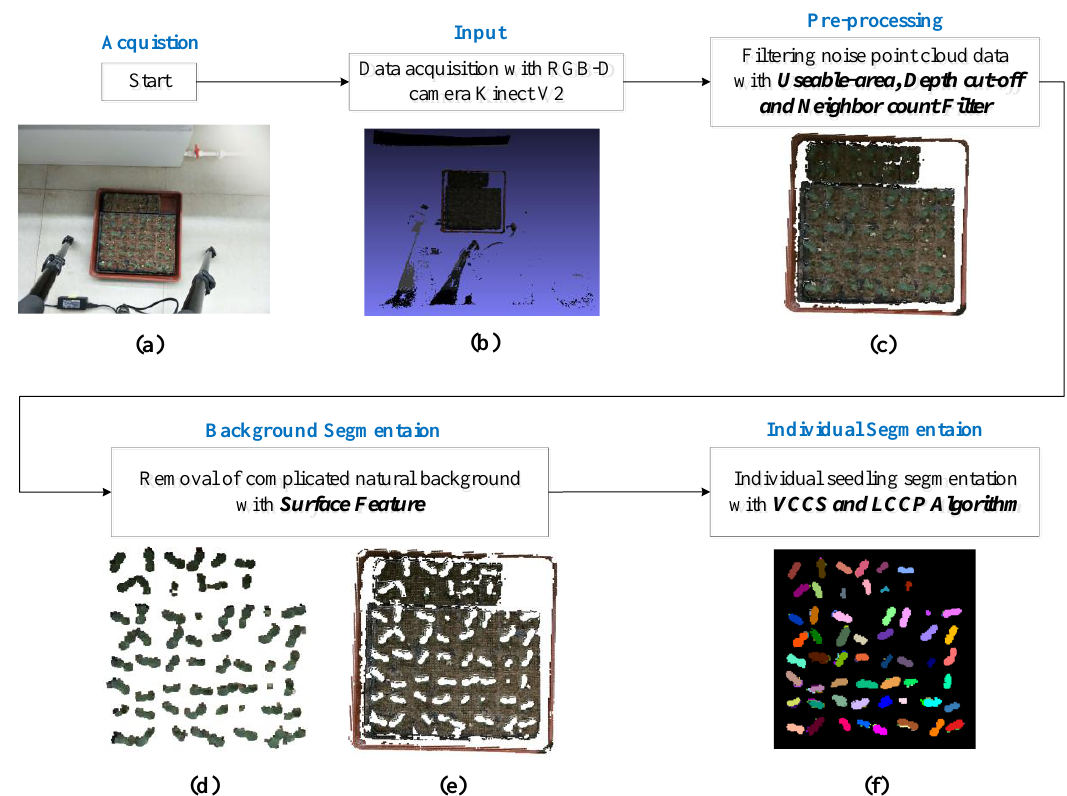
Figure 1. Flowchart of the proposed individual vegetable seedling segmentation scheme. ( a ) The Indoor Scene at Plant Factory, ( b ) The Original Colored Point Cloud, ( c ) The Pre-processed Point Cloud, ( d ) The Seedlings Point Cloud, ( e ) The natural Background Point Cloud, ( f ) The Segmented Individual Seedling.